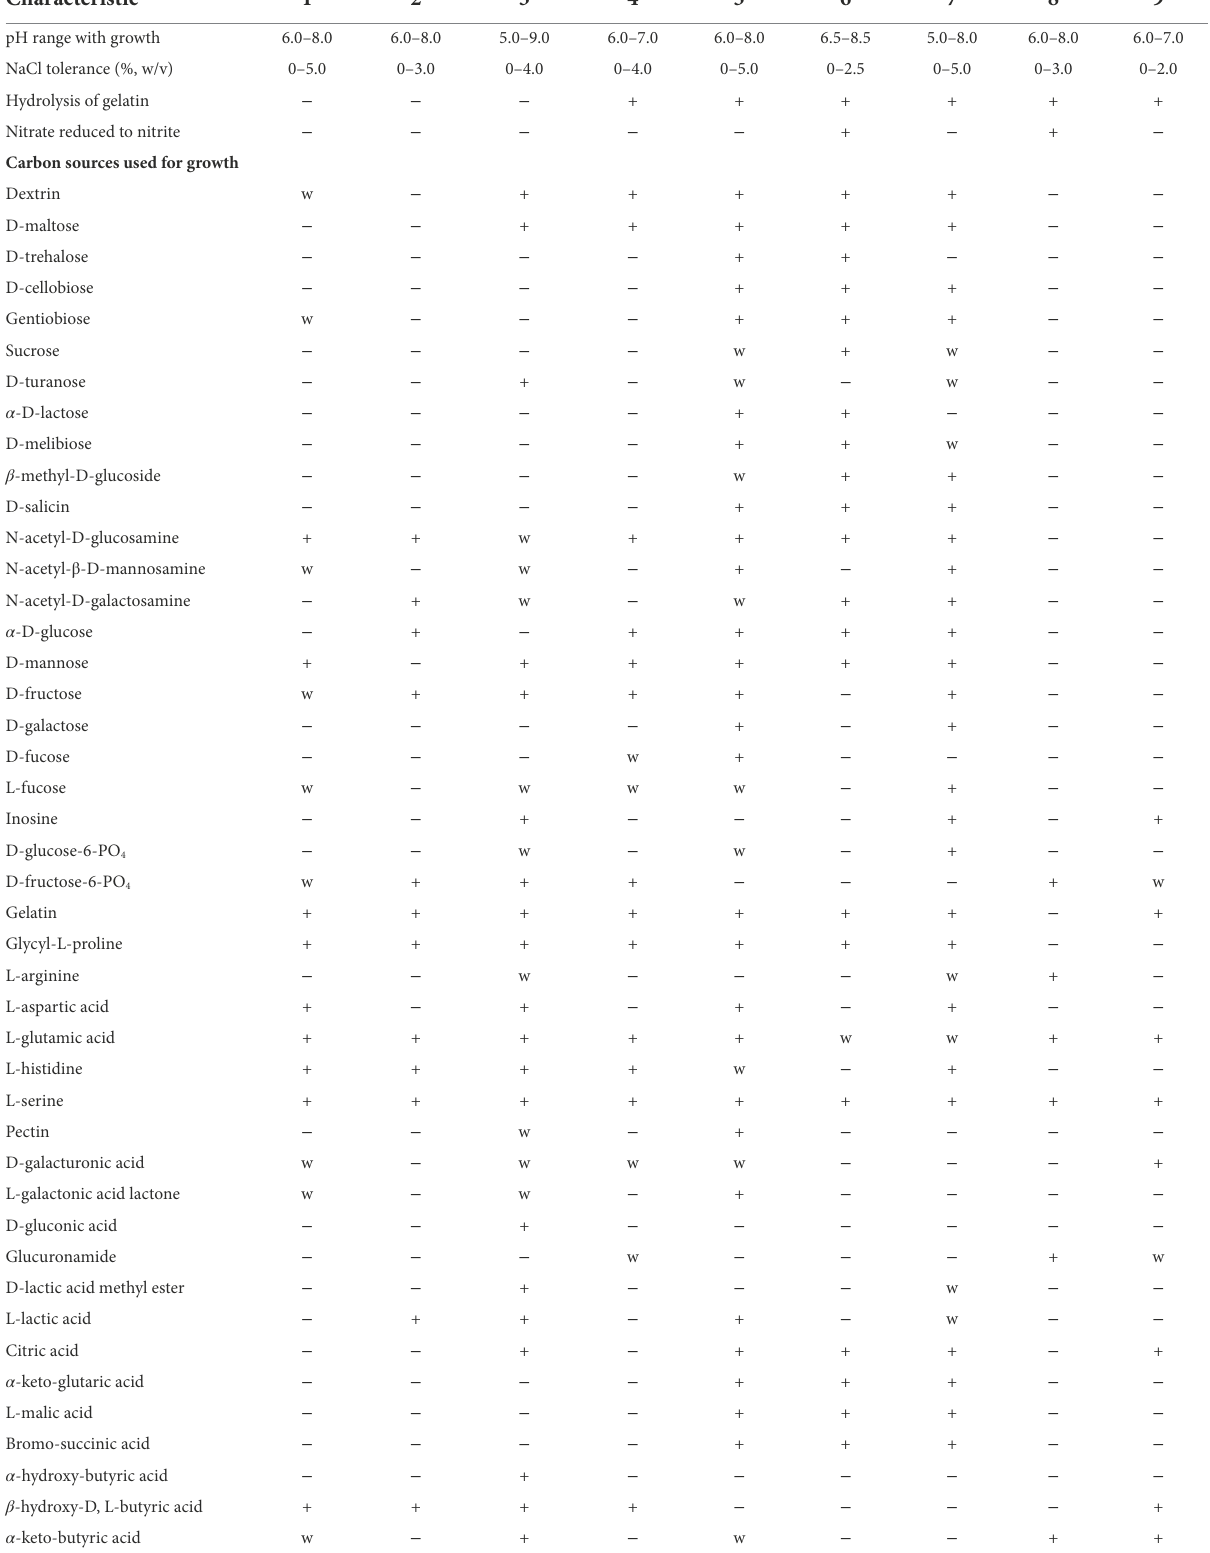
TABLE 1 Physiological characteristics of strains CPCC 101365 T , CPCC 101269 T , CPCC 101426, and the closely related Stenotrophomonas type strains.